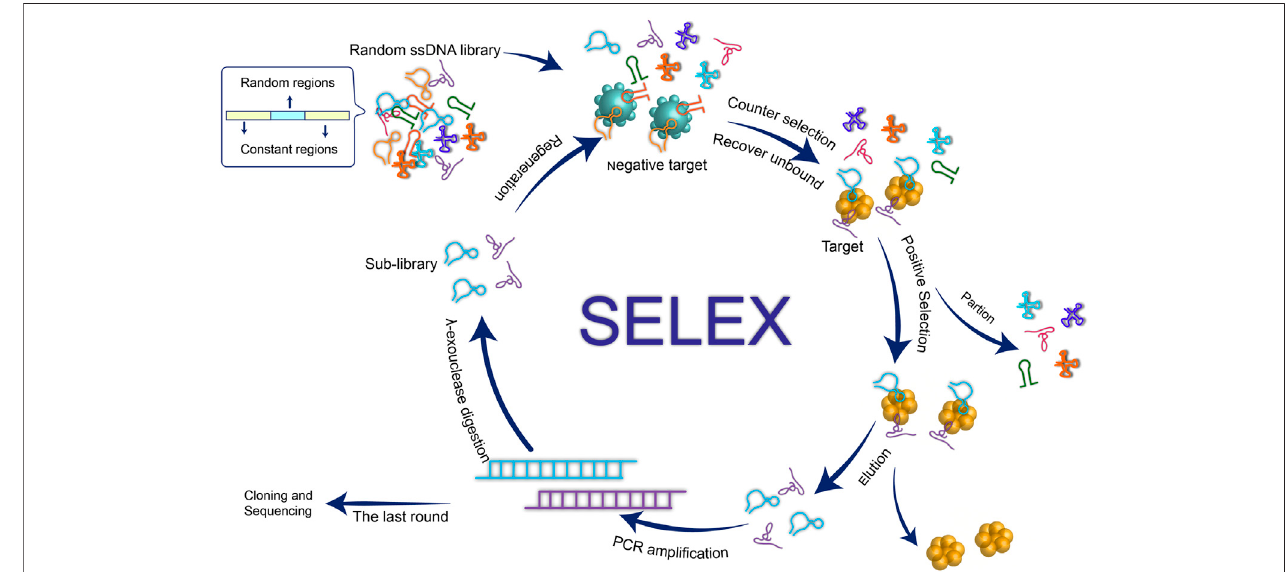
FIGURE 1 | schematic illustration of the aptamer generation by conventional SELEX process.